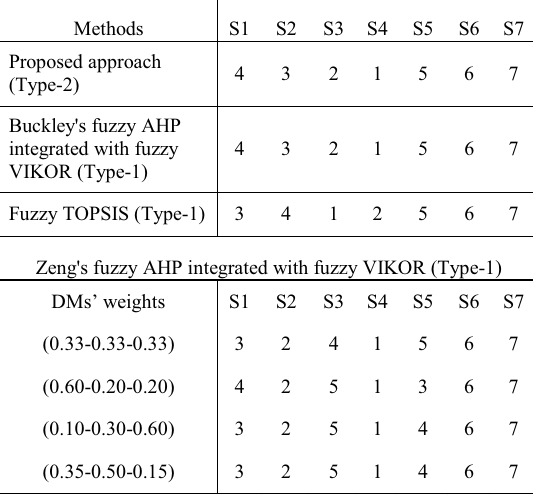
Table 7. Summary of comparison results for sites